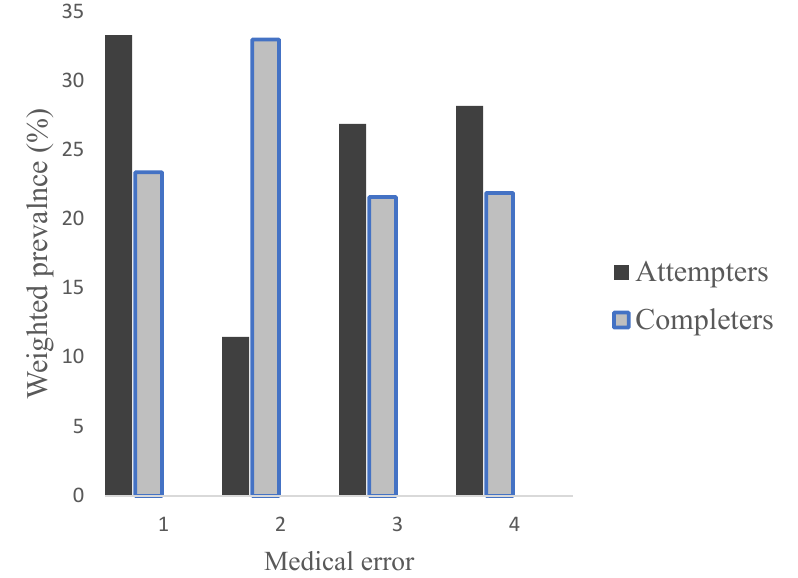
Figure 1. Weighted frequencies (% within each group) for each medical error category by group (attempters vs. completers). 1—Insufficient level of observation/lack of safety measures; 2—Inadequate suicide risk assessment; 3—Inadequate/delayed diagnostic assessment; 4—Inadequate treat- ment.